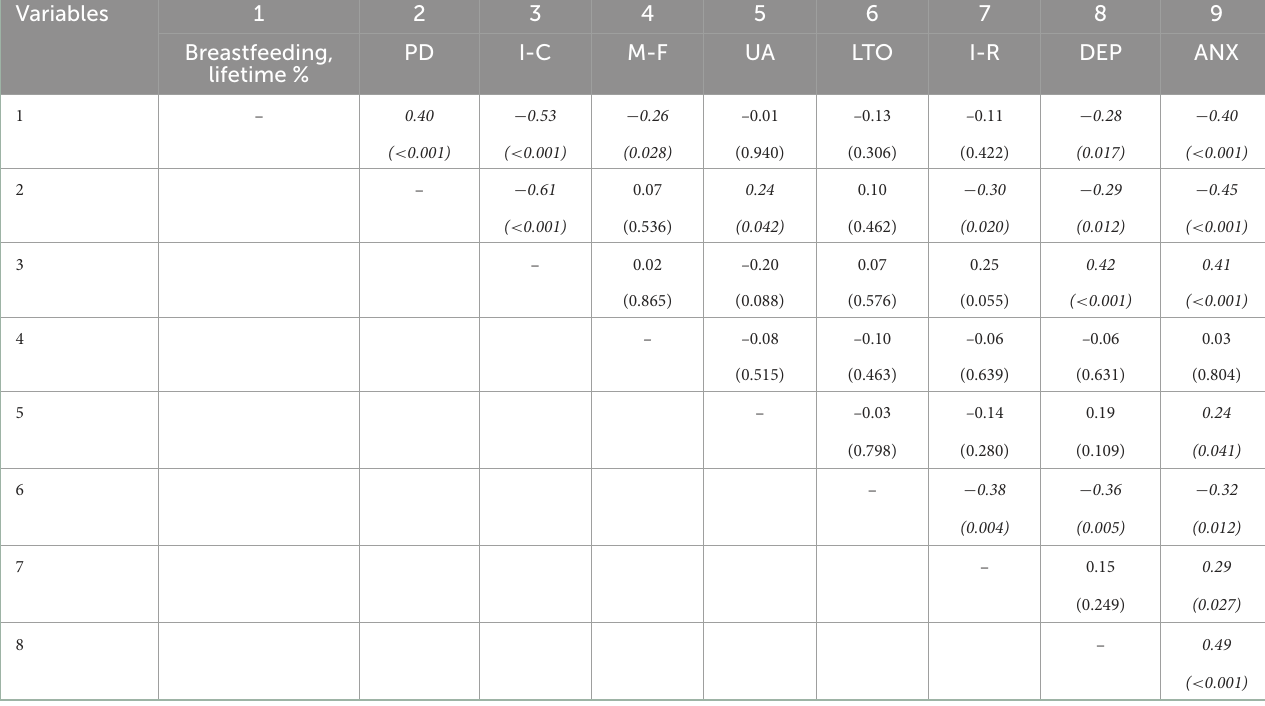
TABLE 3 Exploratory correlations between national lifetime breastfeeding rates, Hofstede’s cultural values, and the prevalence of anxiety and depression in women aged 15–49.